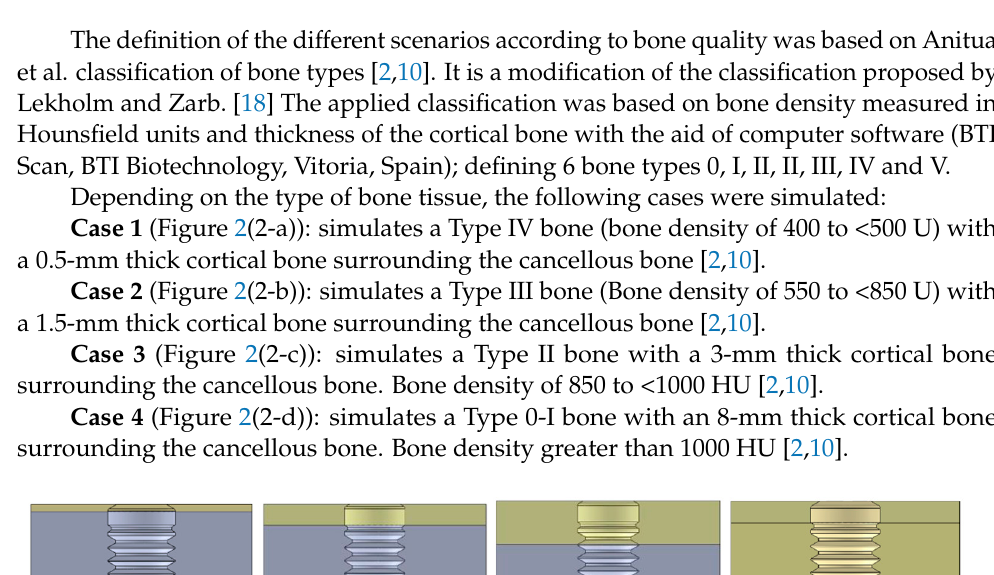
Figure 2. ( 2-a ). Scenario 1, Type IV bone. ( 2-b ). Scenario 2, Type III bone. ( 2-c ). Scenario 3, Type